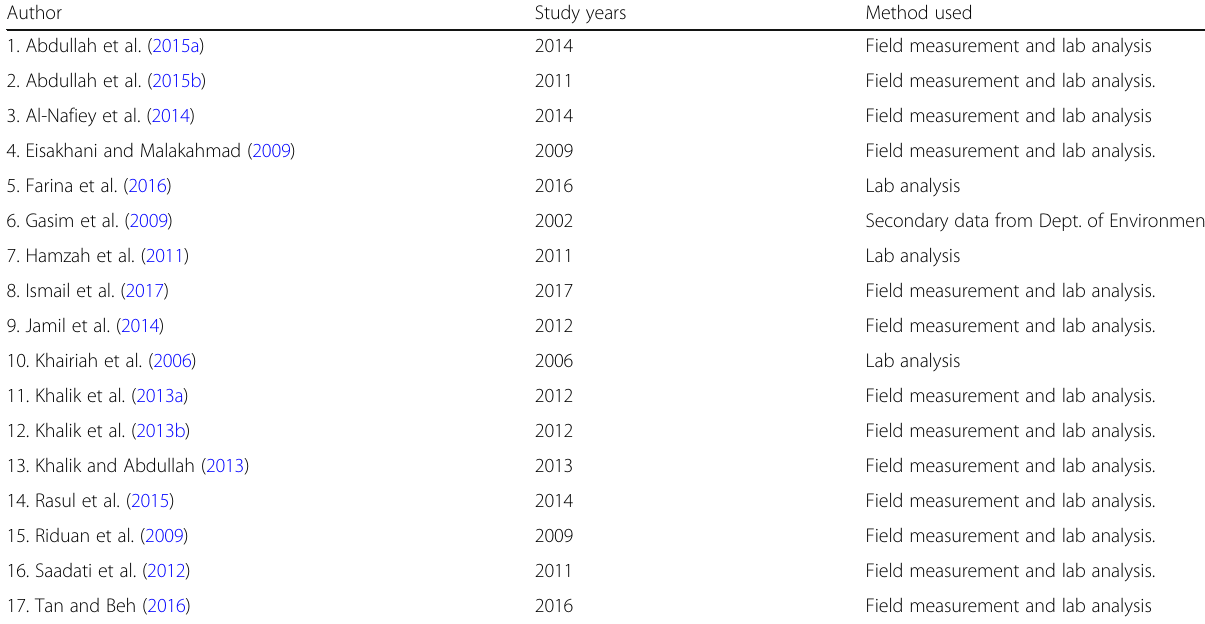
Table 7 Data for river water quality and soil study in Cameron Highlands